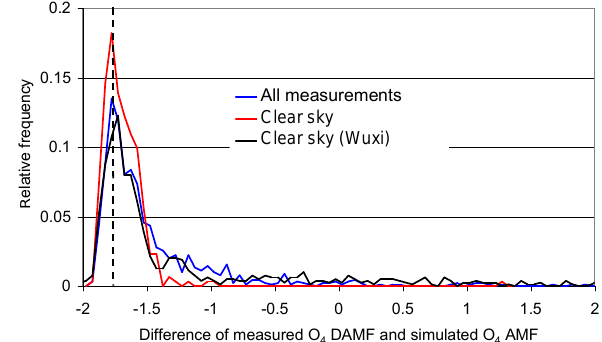
Figure 7. Normalised O 4 DAMF for all measurements (blue) or measurements under clear-sky conditions (red). The normalisation is performed by subtracting the simulated O 4 AMFs for AOD of 0.2. The rectangles indicate the SZA ranges used for the calibration of the O 4 DAMF. The measurements are from the period 12 June to 15 July 2009.